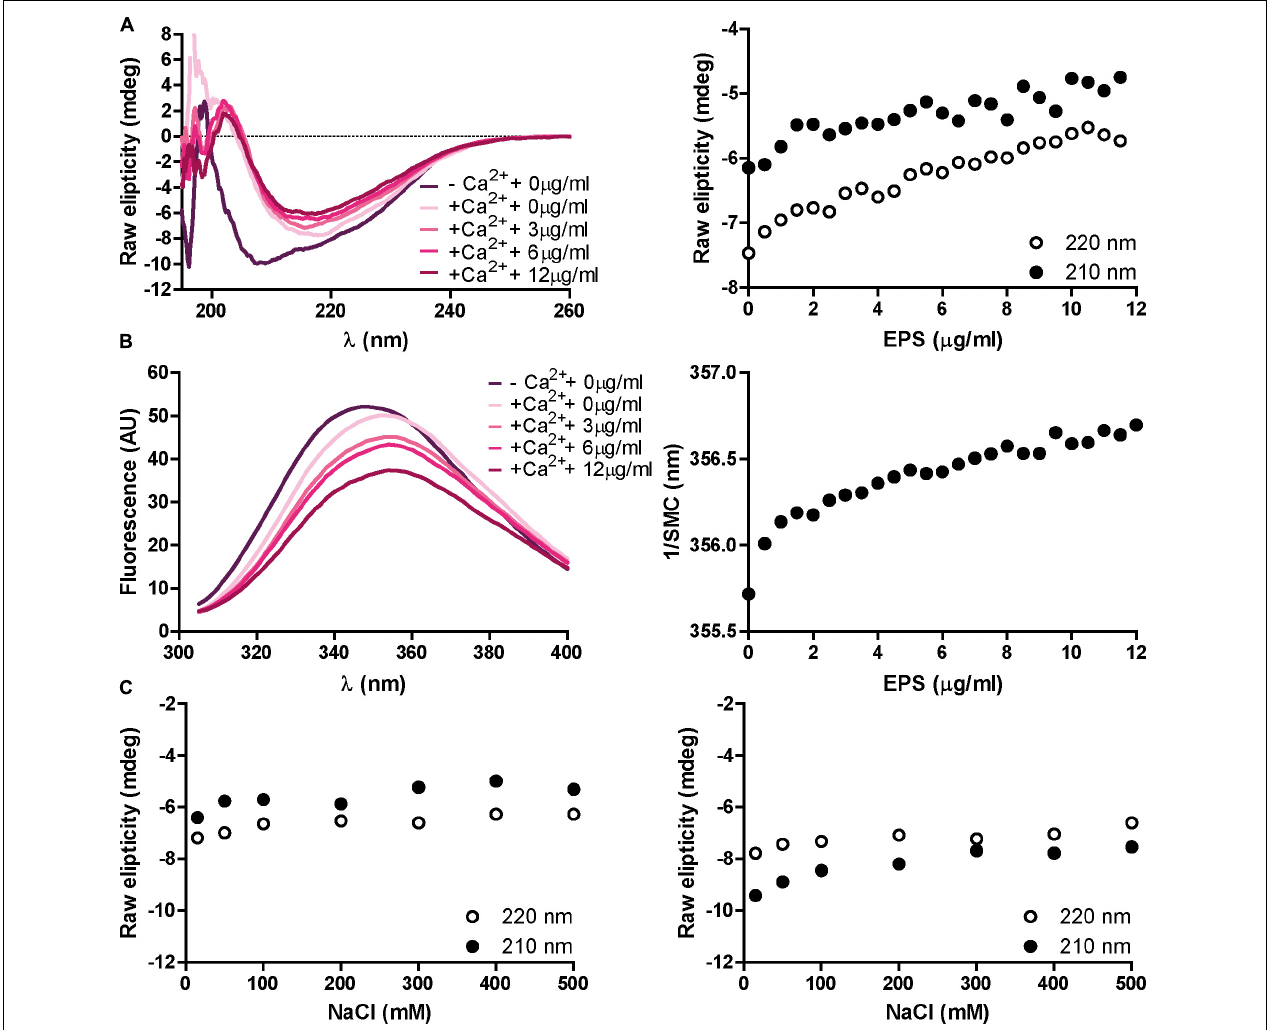
FIGURE 6 | Effect of proteinase K treated EPS on RapD secondary structure and protein environment. (A) Representative far-UV CD spectra for decalcified RapD. RapD was incubated in the presence of 1.25 mM CaCl 2 and 1.25 mM CaCl 2 with increasing concentrations of EPS and raw ellipticity was measured at 210 and 220 nm. EPS concentrations, ranging from 0 to 0.012 µ g/ml are indicated. (B) Representative fluorescence spectroscopy spectra for RapD in the absence of calcium, 1.25 mM CaCl 2 , and 1.25 mM CaCl 2 with increasing EPS concentrations and spectral mass center in response to EPS. (C) Circular dichroism dissociation spectra at increasing NaCl concentrations. Shown in both panels is raw ellipticity at 210 and 220 nm after 30 min of incubation at 25 ◦ C for either RapD and EPS in the presence of calcium (left) or RapD and EPS in the absence of calcium